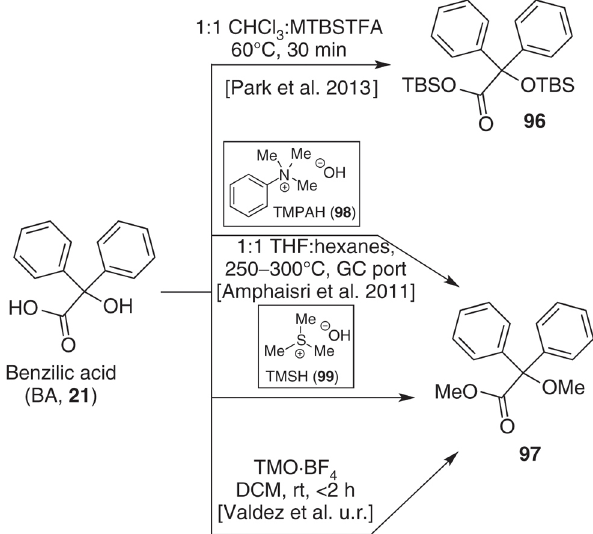
Figure 18: Silylation and methylation strategies for benzilic acid for GC-MS